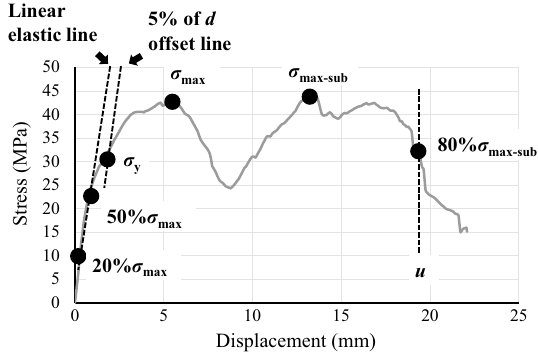
Fig. 9 Evaluation of characteristic values based on the stress– displacement curve. The parameters of the specimen were as follows: panel type, PW-s; d , 5.2 mm; ph , 0; and dowel position,